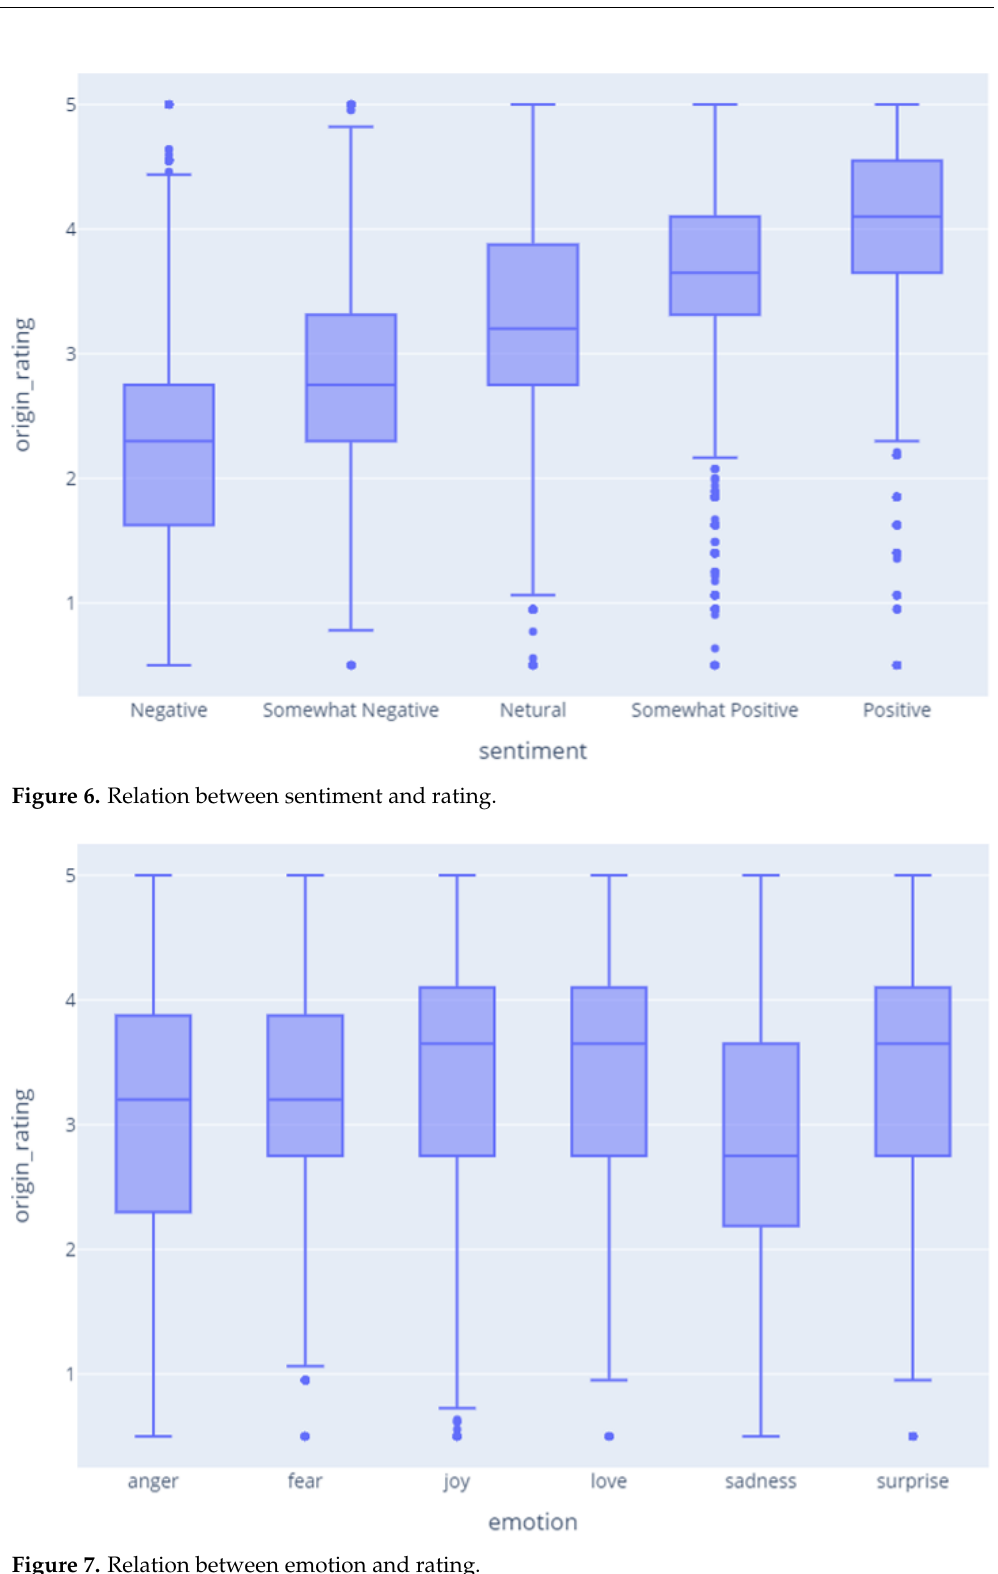
Figure 7. Relation between emotion and